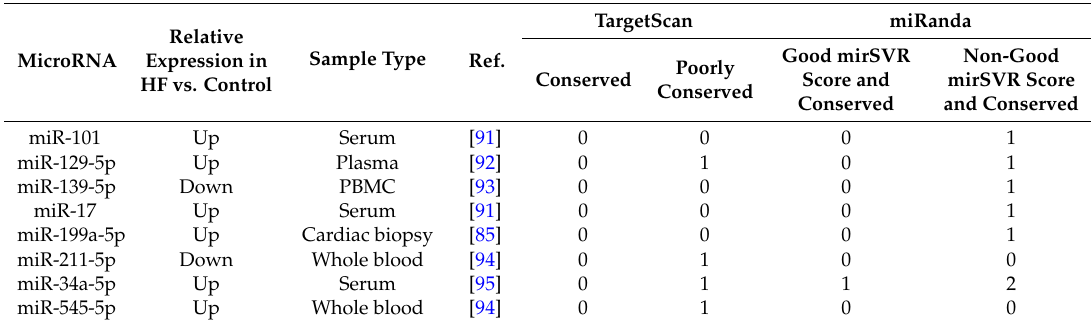
Table 2. HF-related microRNAs and the number of predicted target sites on ANKRD1 -3 (cid:48)